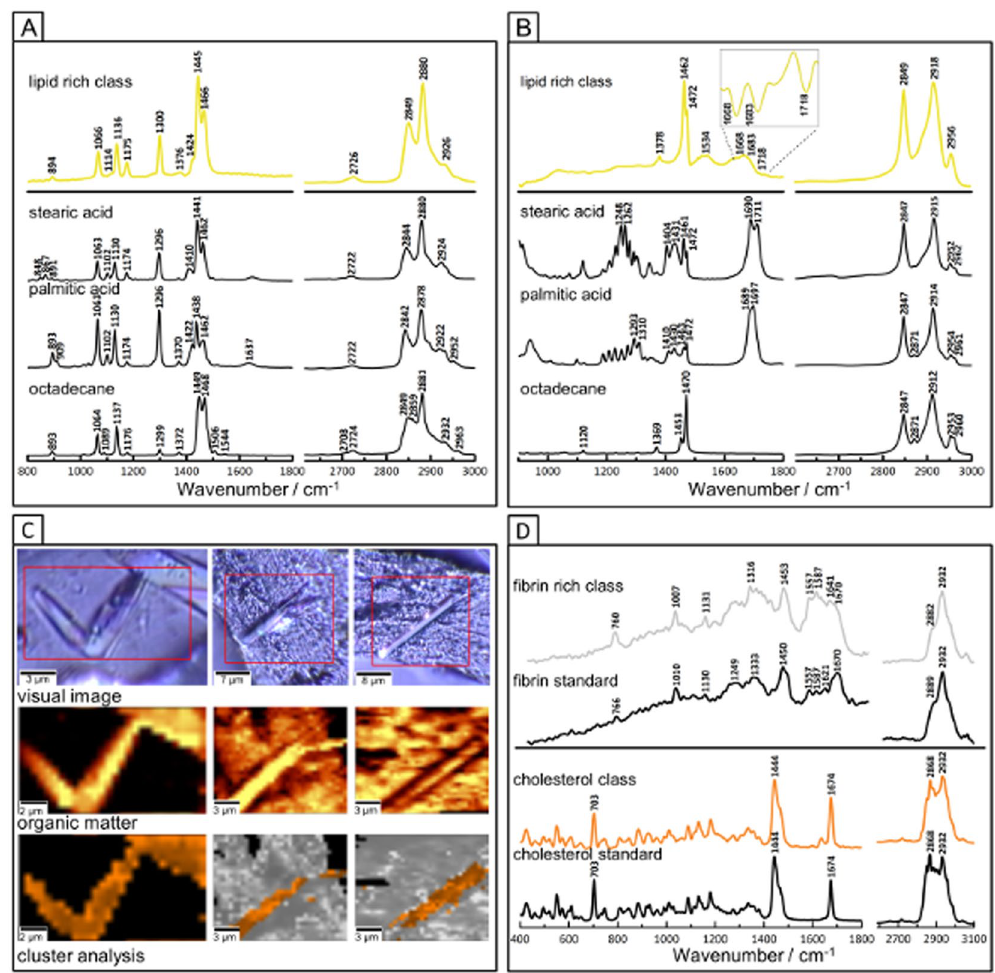
Figure 5. RS and FTIR spectra of lipids in human brain clot of a large vessel origin compared with spectra of standard compounds. ( A ) RS spectra (532 nm excitation) of the averaged lipid–rich grease class presented in Fig. 3 (yellow line) compared to the chosen lipid standards; ( B ) FTIR spectra of the averaged lipid–rich grease class presented in Fig. 2B compared to the chosen lipid standards; ( C ) RS CA images of the cholesterol crystals and fibrin–rich class; ( D ) the mean RS spectra of to the classes presented in C compared to standards of fibrin and